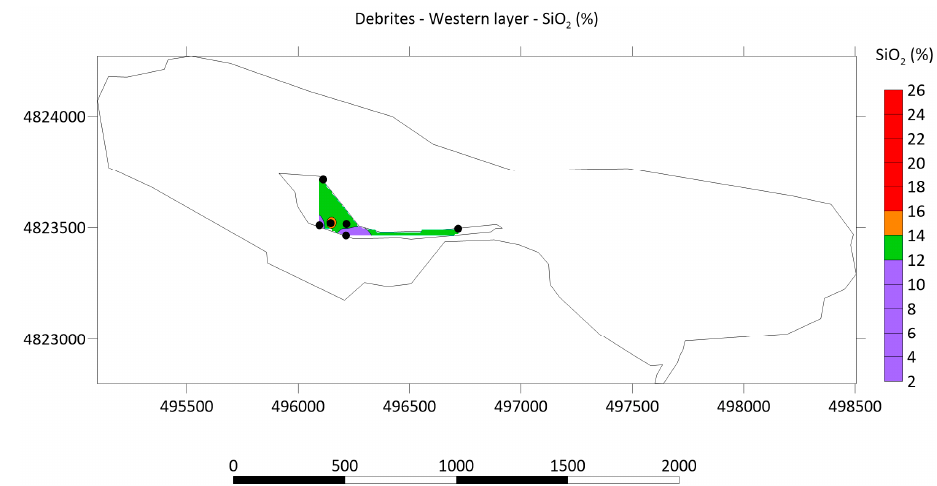
Figure 15 . Map of CaO (%) in unit (7), western layer (boreholes are black dots).